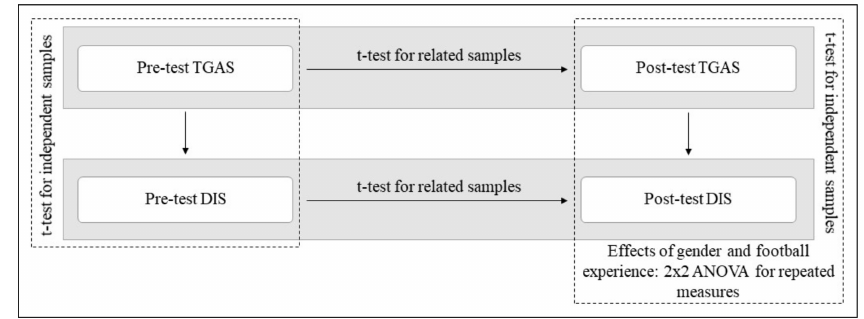
Figure 2. Statistical tests used to compare the declarative and procedural knowledge in the pre-test and post-test. Note: TGAS: Tactical Games Approach Soccer. DIS: Direct Instruction Soccer.